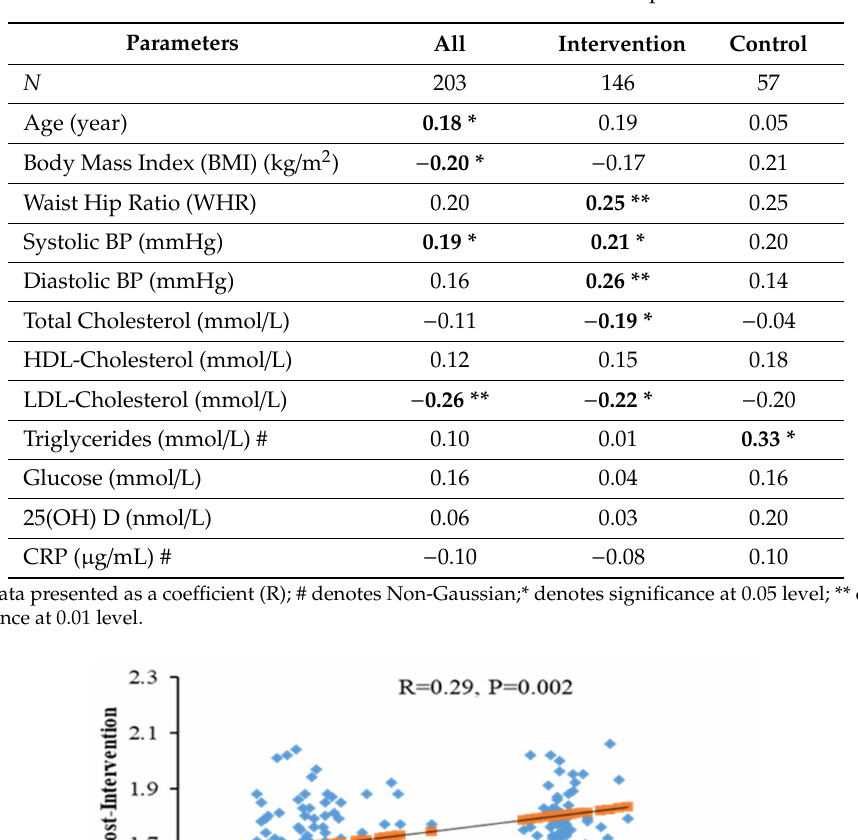
Table 3. Baseline GPx1 Associations in All Groups.